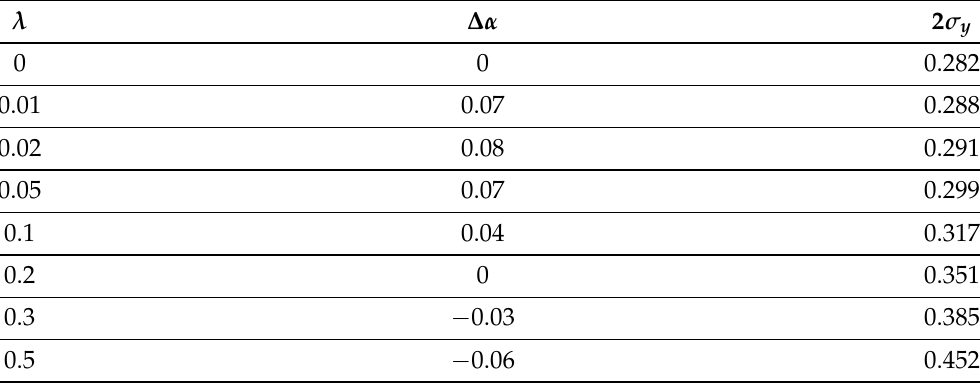
Figure 15. High performance control (minimal output variance—reflected by 2 σ y ) against corre- sponding λ for various ∆ α values ( left ), and the ∆ α as a function of λ penalty factor ( right ). Table 2. Simulation results of Example